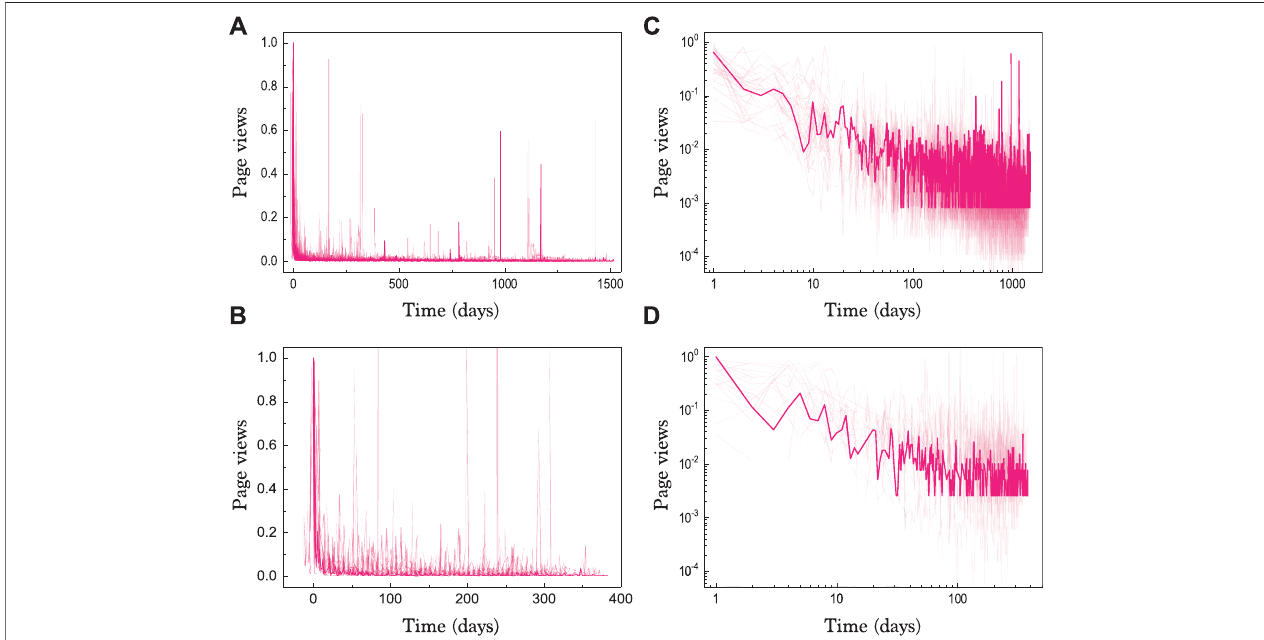
FIGURE1| Statisticsofarticlepageviewsafteronlinepublication. Thenormalizedpageviewsaredescribedinthenormal scales (A,B) andinthelognormal scales (C,D) . The fi rst dataset is taken from 42 articles published in Scienti fi c Reports in 2012 (A,C) and the second dataset from 19 articles published in Scienti fi c Reports between January and May in 2015 (B,D) , showing more than 1,000 views at the early stage of online publication. As a guide, the arbitrary selected data for srep00223 (A,C) and srep07971 (B,D) are marked with the solid line, respectively. Most interestingly, fast decays in the early stage and slow decays in the late stage can be